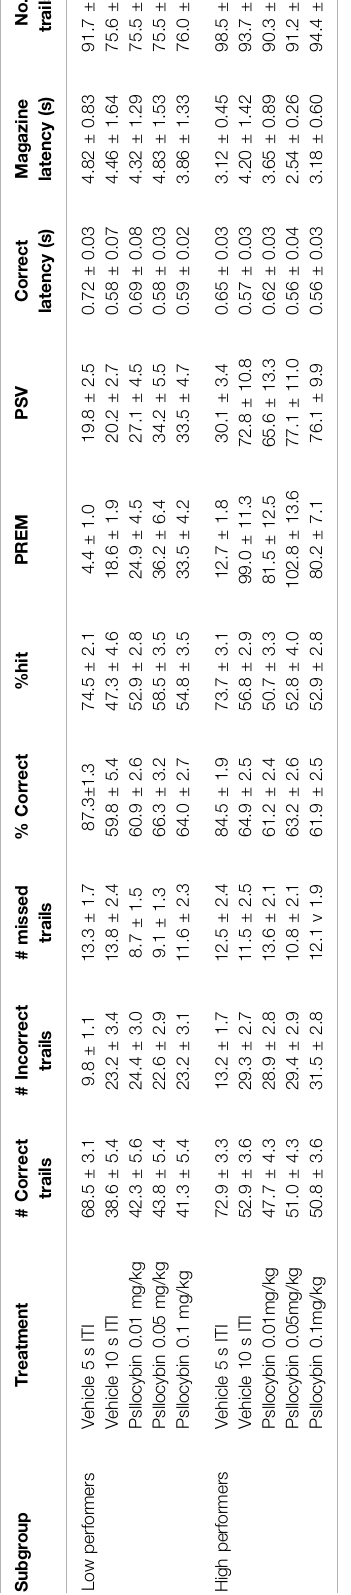
TABLE 8 | Calculated pharmacokinetic measures for